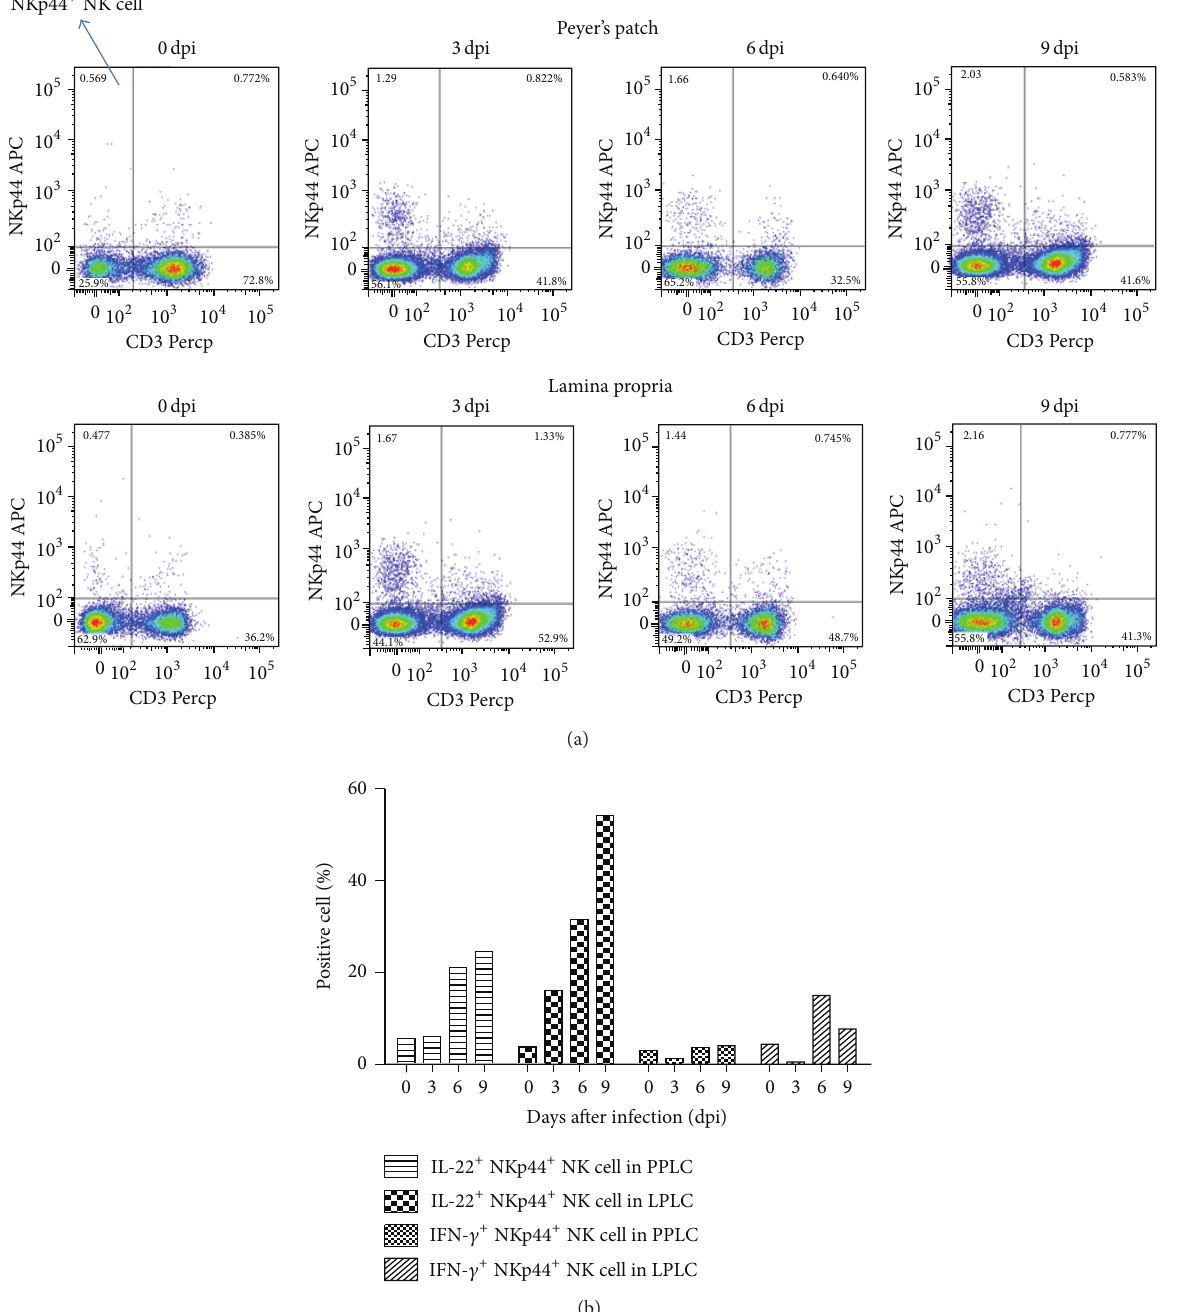
Figure 6: Number of and IL-22 secretion from mucosal natural killer (NK)p44 + NK cells increased in the early acute phase before occurrence of microbial translocation (MT). (a) Number of mucosal NKp44 + NK cells (upper left quadrant) at the early acute phase of simian immunodeficiency virus (SIV) infection. (b) IL-22 or IFN- 𝛾 secretion of mucosal NKp44 + NK cells during early acute phase of SIV